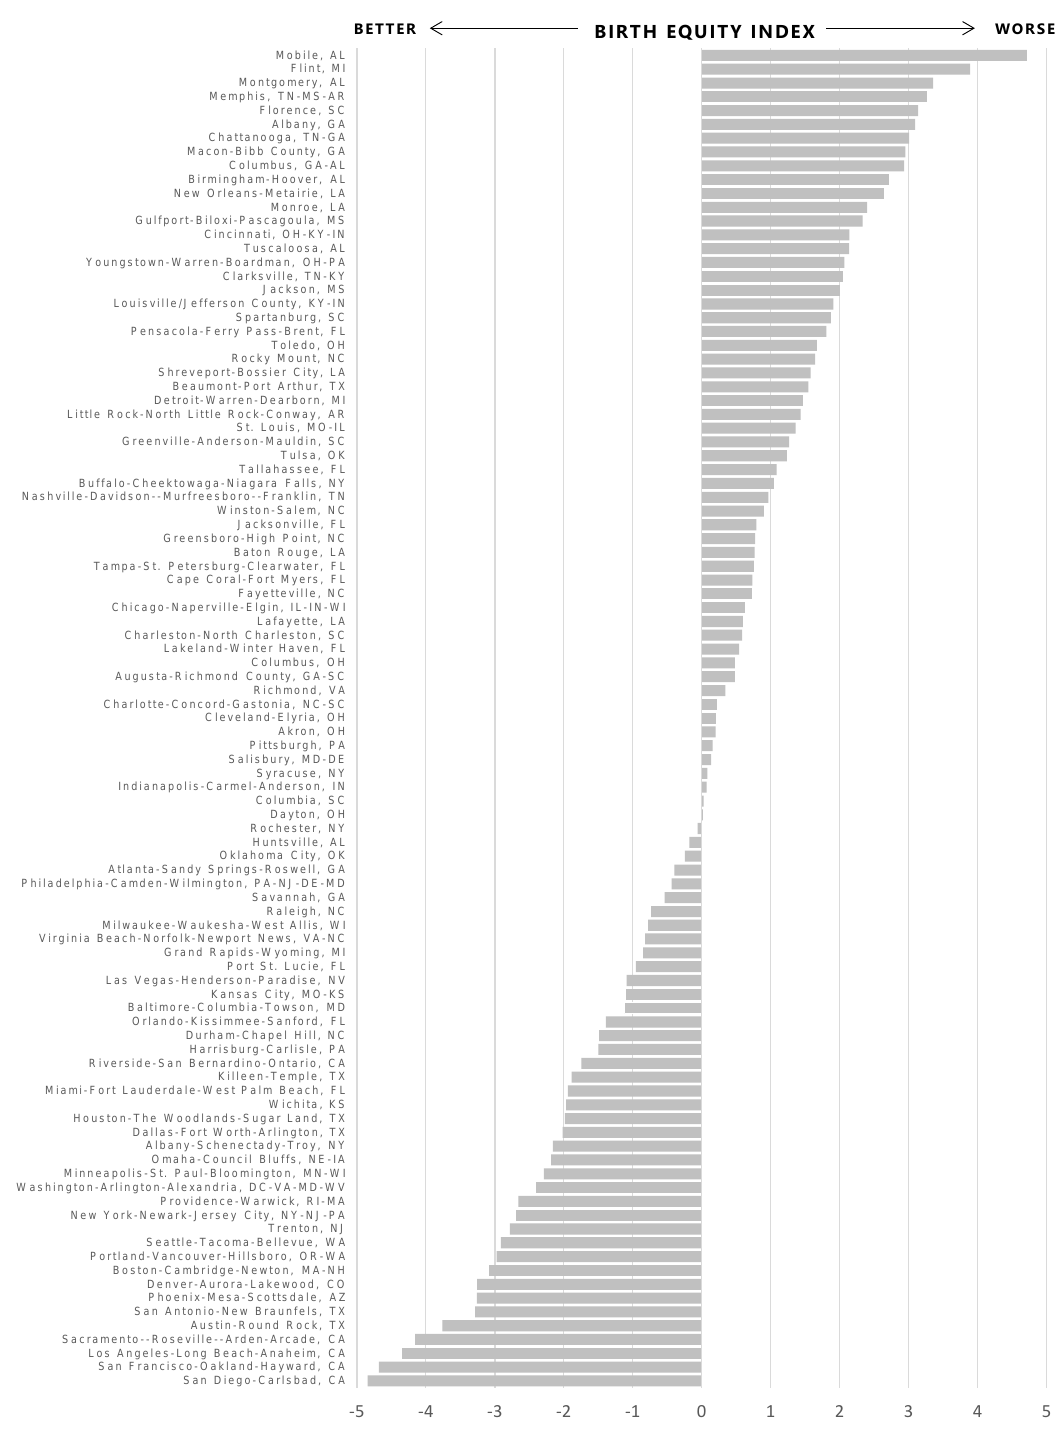
Figure 1. Values of the Birth Equity Index by metropolitan statistical